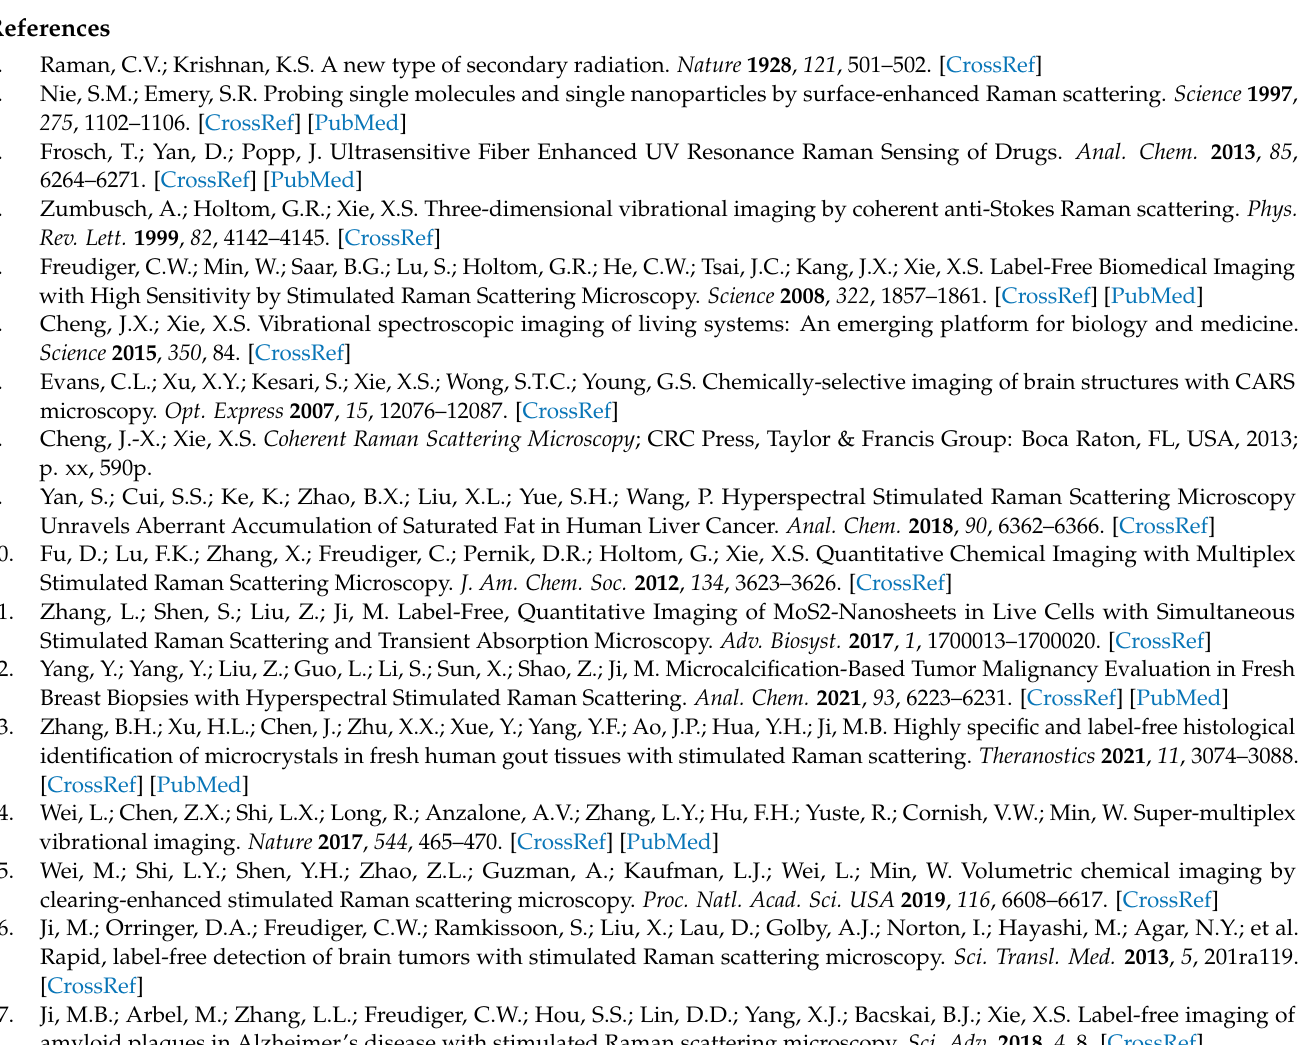
Figure S1: Attenuation properties of the laser beams in MLHCF; Figure S2: Spontaneous Raman spectra of ethanol and DMSO; Figure S3: Theoretical relationship between SRS signal intensity and fiber length; Figure S4: The linear relationship between SRS intensity and analyte concentration; Figure S5: The relationship between the fiber length of the maximum SRS intensity and Raman gain coefficient and attenuation